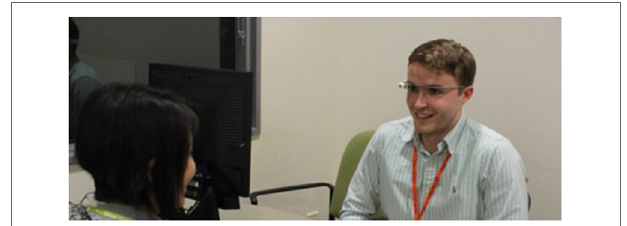
FigUre 2 | Example use of Holli in a